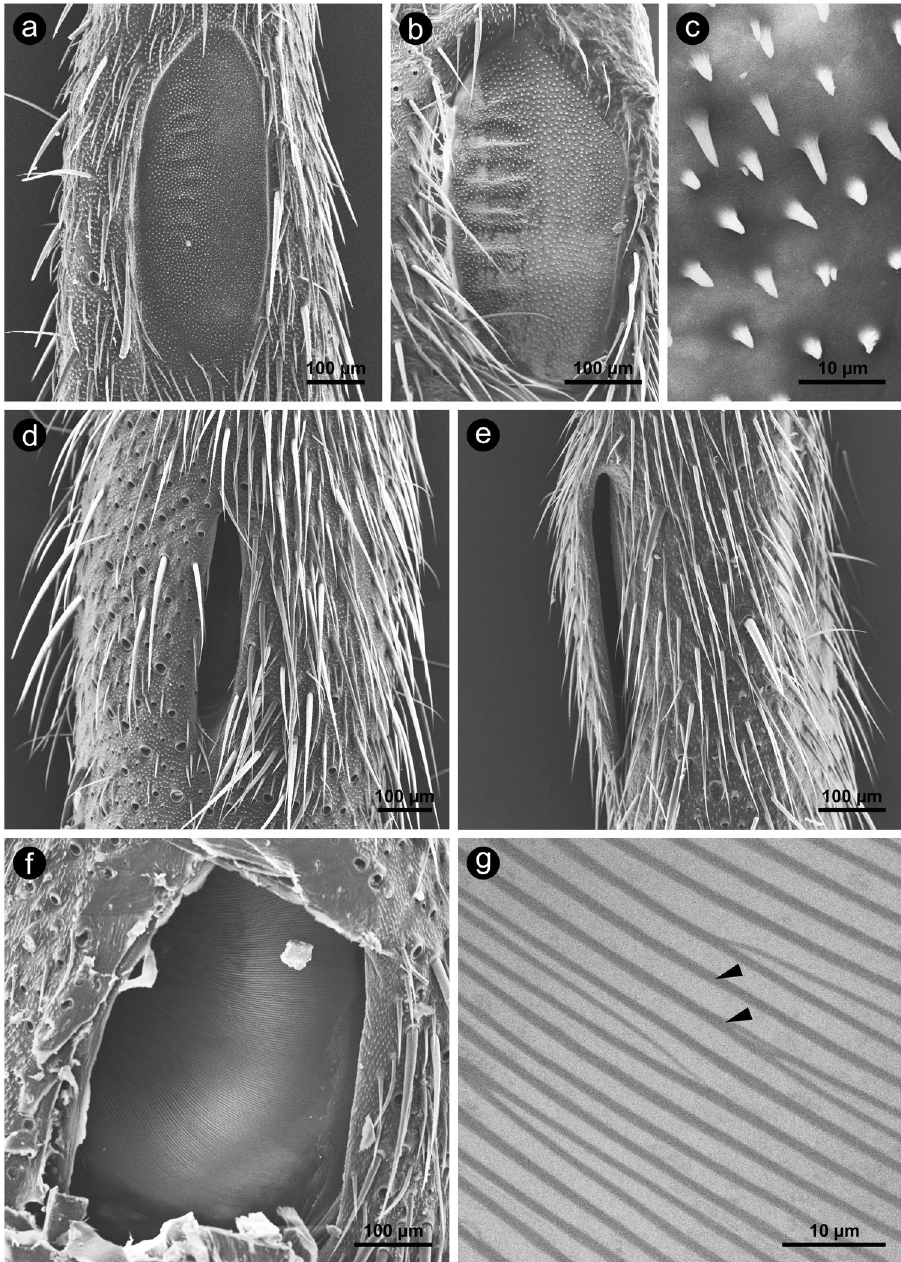
Figure 2. SEM-micrographs of the proximal tibia of Eneopterinae crickets, showing different aspects of the posterior (PTM, a – c ) and anterior tympanum (ATM, d – g ). ( a ) PTM of G . baitabagus , ( b ) PTM of N . vittatus in overview and ( c ) at higher magnification, showing a uniform surface covered by microtrichia, ( d ) anterior view of the slitted ATM of M . jharnae , ( e ) medial view of the slitted ATM of N . vittatus , ( f ) anterior view of the ATM of C . sumba after removal of the cap that covers the ATM in the native state; overview ( f ) and at higher magnification ( g ), arrowheads indicate taenidia that are visible in SEM-micrographs because of the very low thickness of the ATM. Orientation in ( a – d , f and g ): top = proximal; bottom = distal; left = lateral; right = medial. Orientation in ( e ): top = proximal; bottom = distal; left = anterior; right =